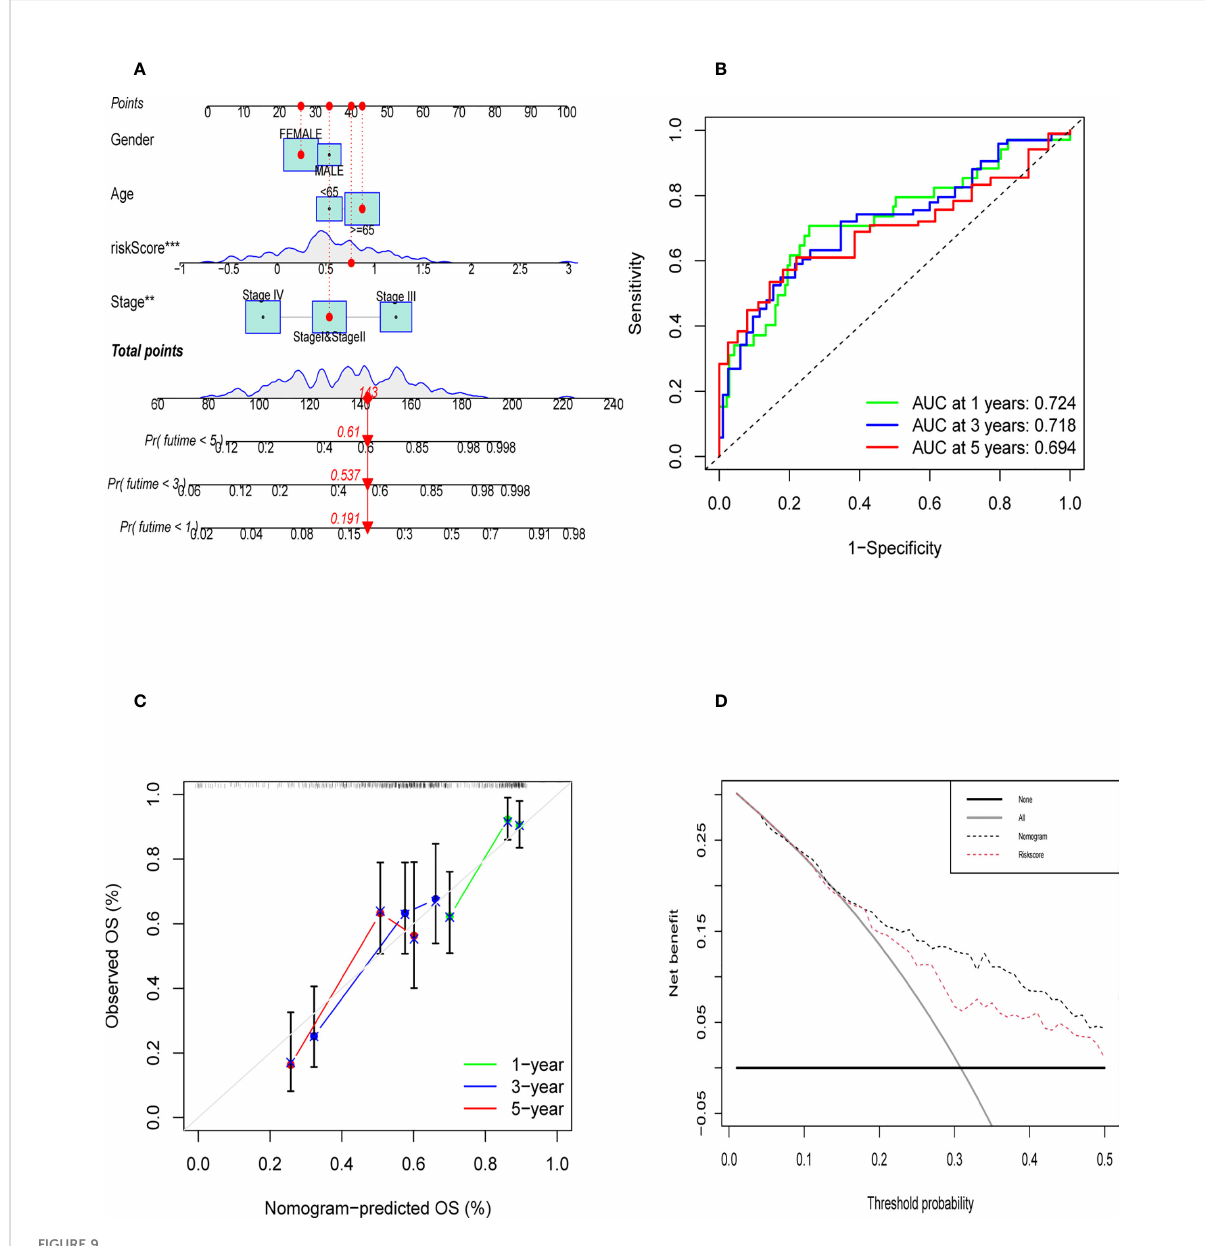
FIGURE 9 Evaluation of Validation of Nomogram. (A) The nomogram was established to predict the prognosis of patients. (B) The time-dependent ROC curve was shown the accuracy of our nomogram (C) The calibration curve of nomogram that predict the 1,3,5 year survival rate. (D) DCA curve was shown that the nomogram was better than riskscore on predicting survival rate of